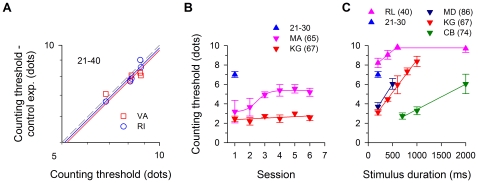
Control experiments.(a) Retinal illumination and optical blurring. The counting performance is minimally affected by lowered retinal illumination (RI, 2%), and optical blurring to 20/20 (VA, 4%) in five young observers. The colored lines represent the average data for these two conditions. A gray, dashed 1∶1 reference line is plotted for comparison. (b) Visual learning. Practice improves counting performance, though to a different extent, in two older adults, however the improved performance is still not comparable with that of young adults. Each training session consisted of 400 trials, a total of 2400 trials in 6 sessions. In this and subsequent panels, observers' age was indicated in parenthesis. (c) Stimulus duration. The effect of stimulus duration is investigated in three older adults with the lowest counting threshold. For comparison, another younger adult was tested for a range of duration.